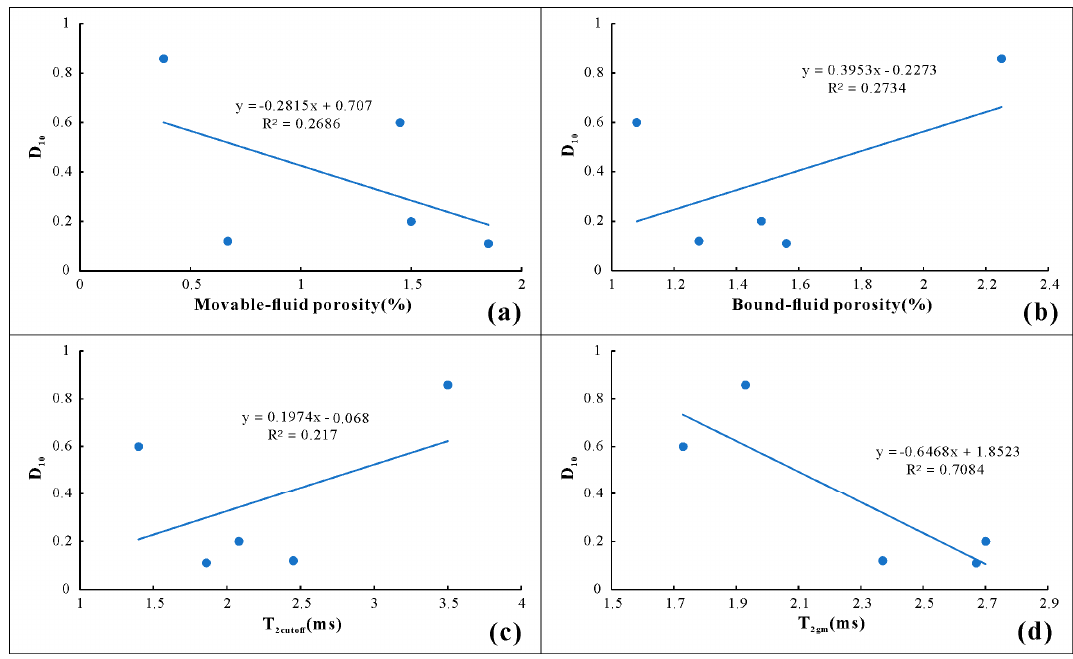
Figure 11. The correlations between multifractal parameter D 10 and NMR pore structure parameters. ( a ) the correlation between D 10 with movable-fluid porosity; ( b ) the correlation between D 10 with bound-fluid porosity; ( c ) the correlation between D 10 with T 2cutoff ; ( d ) the correlation between D 10 with T 2gm .